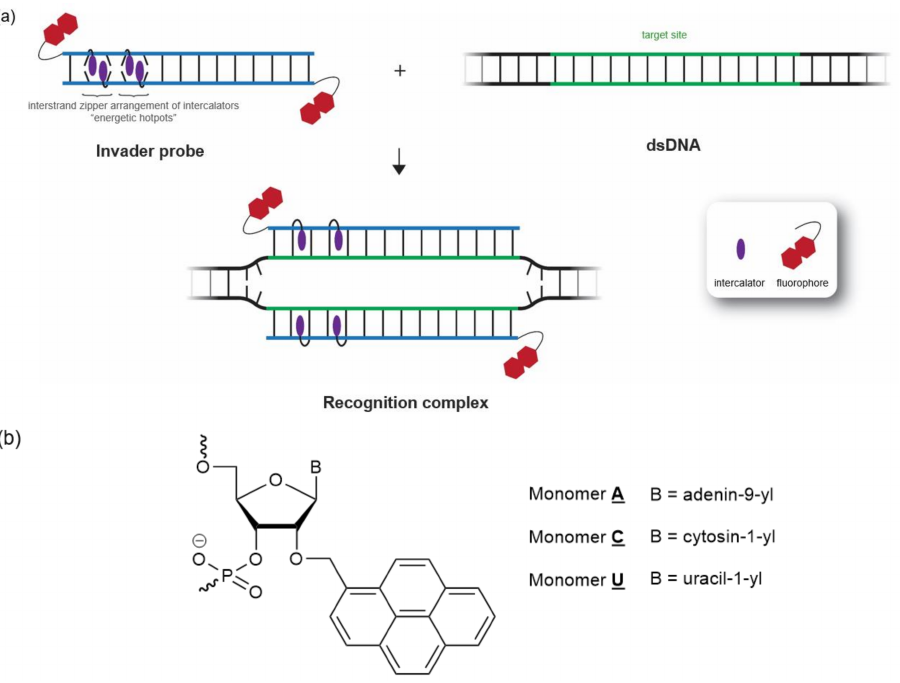
Figure 1. ( a ) Illustration of Invader-mediated recognition of dsDNA via a double-duplex invasion process. ( b ) Structures of Invader monomers used